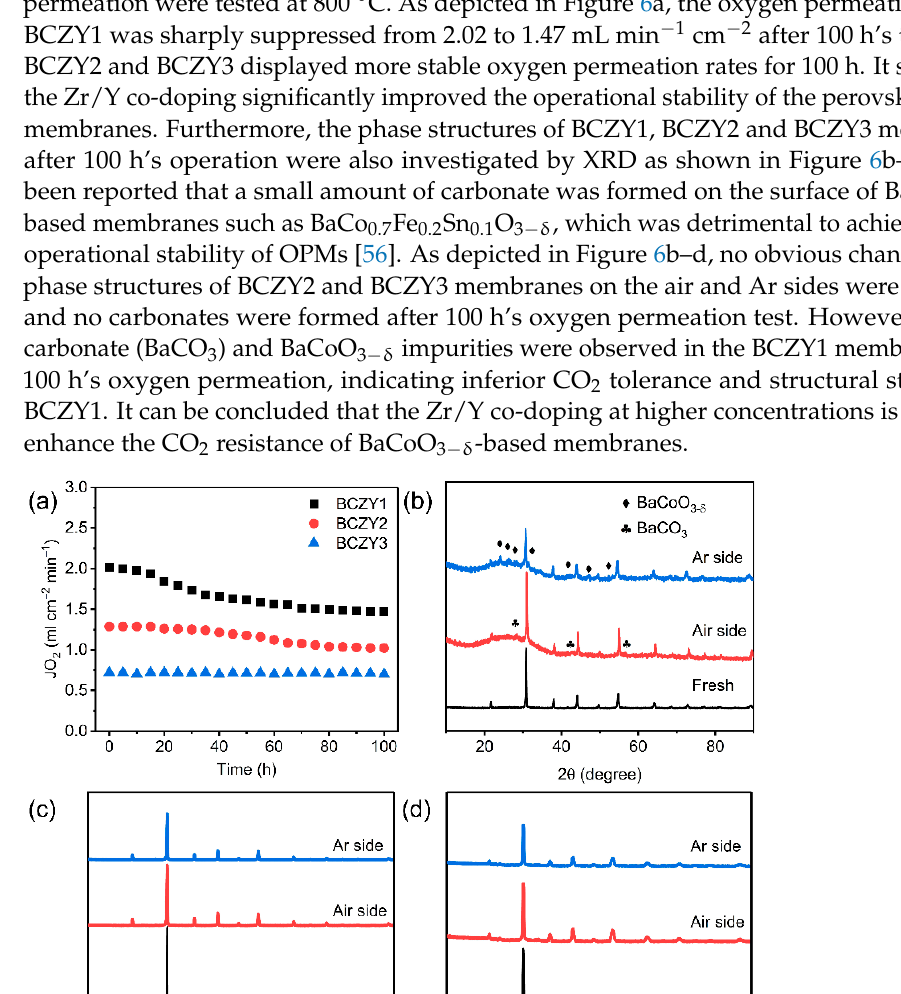
Figure 5. ( a ) Electrical conductivities of BCZY1, BCZY2, BCZY3 in air; Arrhenius plots of ( b ) D chem and ( c ) K chem values of BCZY samples obtained by ECR.